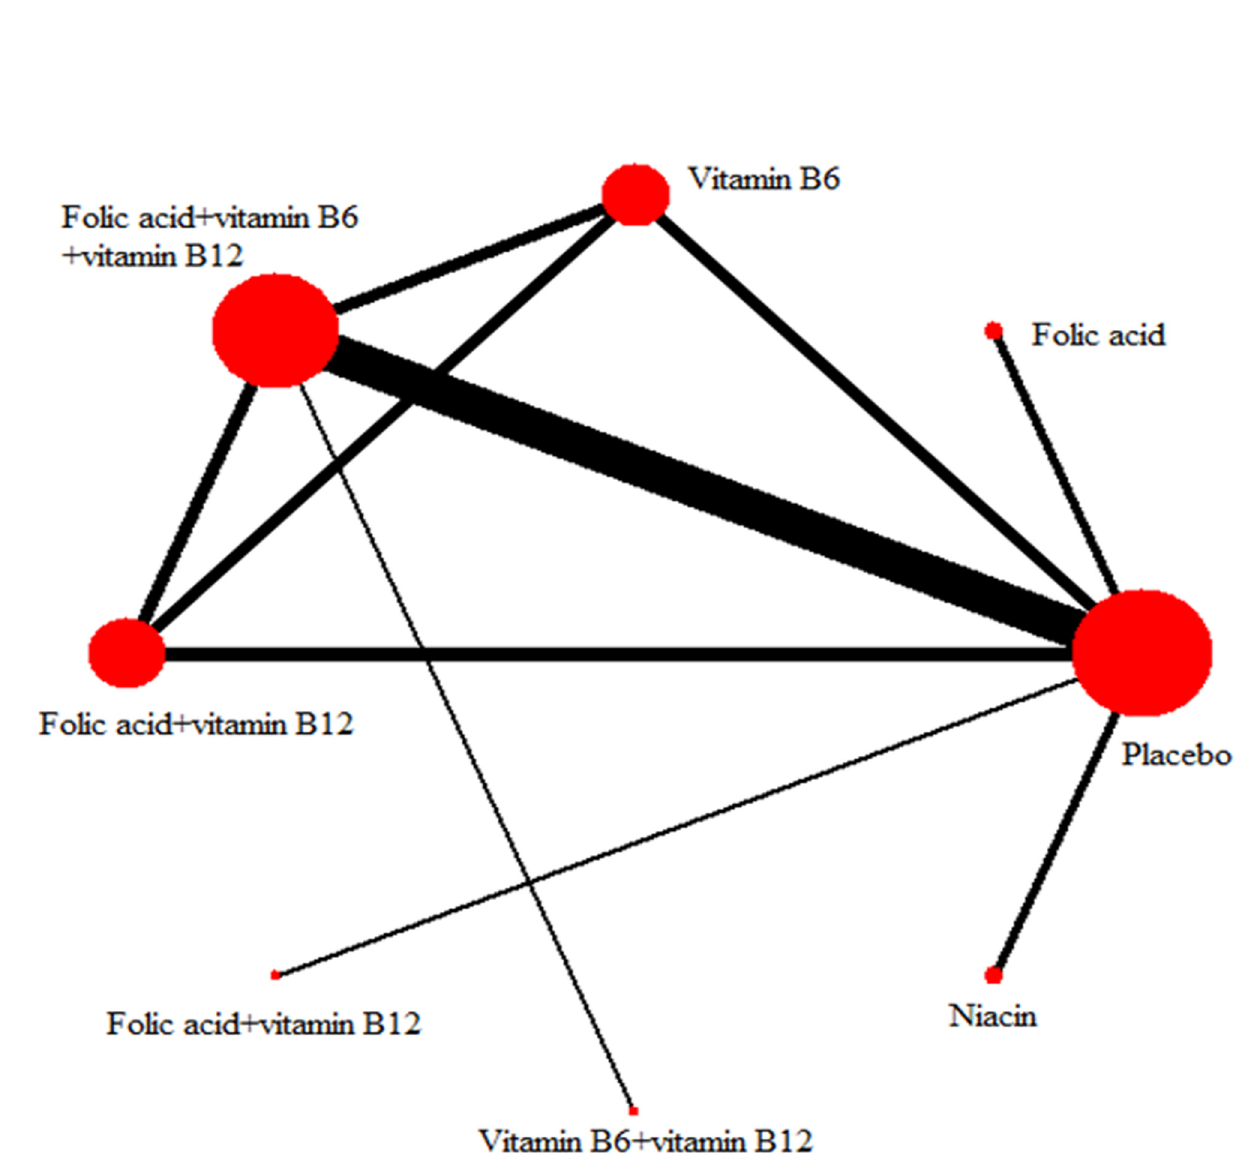
Fig 2. Evidence network of B vitamin interventions included in the network meta-analysis for efficacy. The size of the node corresponds to the number of randomized participants (sample size), and the width of the line corresponds to the number of trials comparing each pair of treatments.